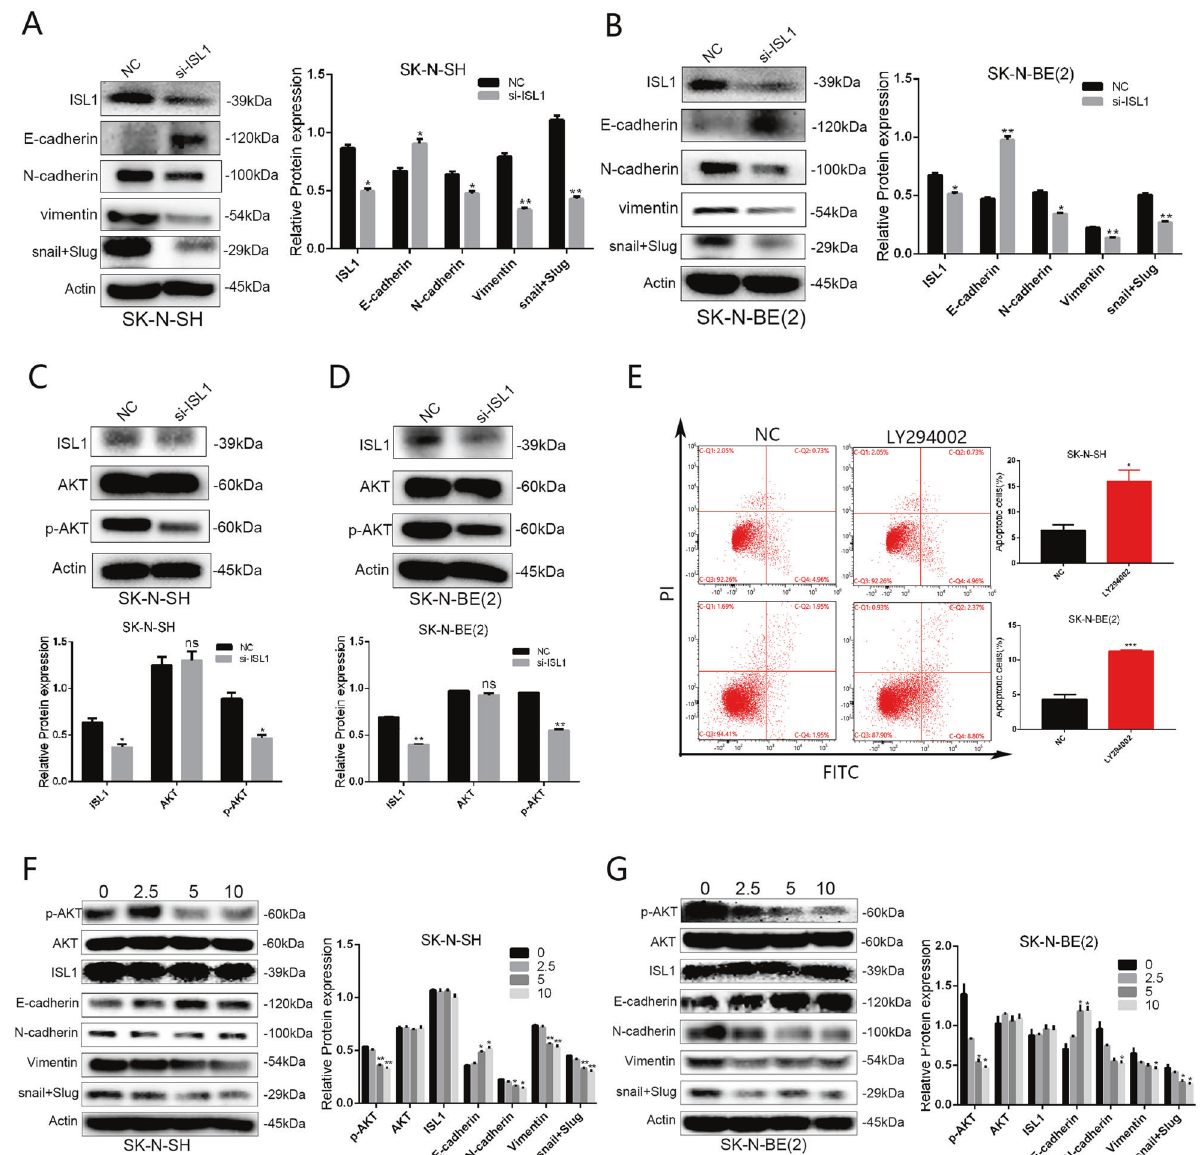
Fig. 7 ISL1 promoted EMT in NB cell lines through PI3K/AKT signal pathway. A , B Expression changes of EMT-associated markers (epithelial marker: E-cadherin, mesenchymal markers: N-cadherin, vimentin, and Slug) in SK-N-SH and SK-N-BE (2) cells after ISL1 was downregulated by si-ISL1-2. C , D WB analysis of total AKT and p-AKT in SK-N-SH and SK-N-BE (2) cell lines after transfection with si-ISL1-2. E Apoptosis analysis of SK-N-SH and SK-N-BE (2) cell lines treated with PI3K inhibitor LY294002 for 48 h. F Comparison of ISL1, AKT, p-AKT protein, and EMT-associated markers ’ expression in SK-N-SH and SK-N-BE (2) cells with or without using PI3K inhibitor LY294002 (concentration at 0, 2.5, 5, and 10 μ M. * P < 0.05, ** P < 0.01, *** P <